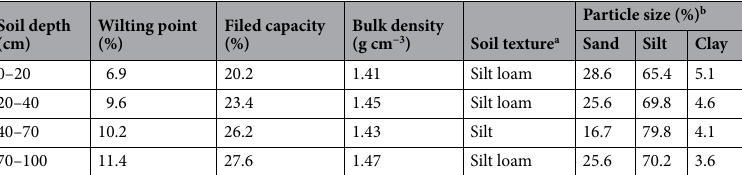
Table 1. Main soil properties across 0–100 cm soil profile at the Oasis Agricultural Experimental Station, China. a Soil texture was determined according to soil particle percentage. b Soil particle fraction was determined based on the USDA textural soil classification